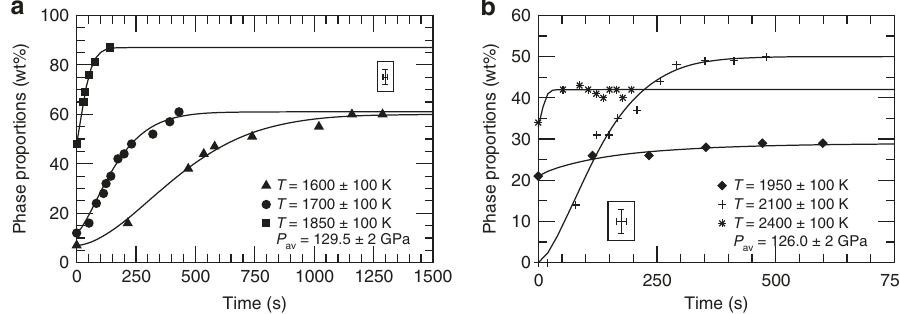
Fig. 2 Phase transformation vs. time. pPv weight proportions measured vs. time at a 1600 K, 1700 K, 1850 K, and 129.5 GPa and b 1950 K, 2100 K, 2400 K, and 126.0 GPa. Symbols are data extracted from the Rietveld re fi nements. Solid lines are fi ts of the Avrami model (Table 1). Insets: representative ± 1 σ uncertainties on the experimental